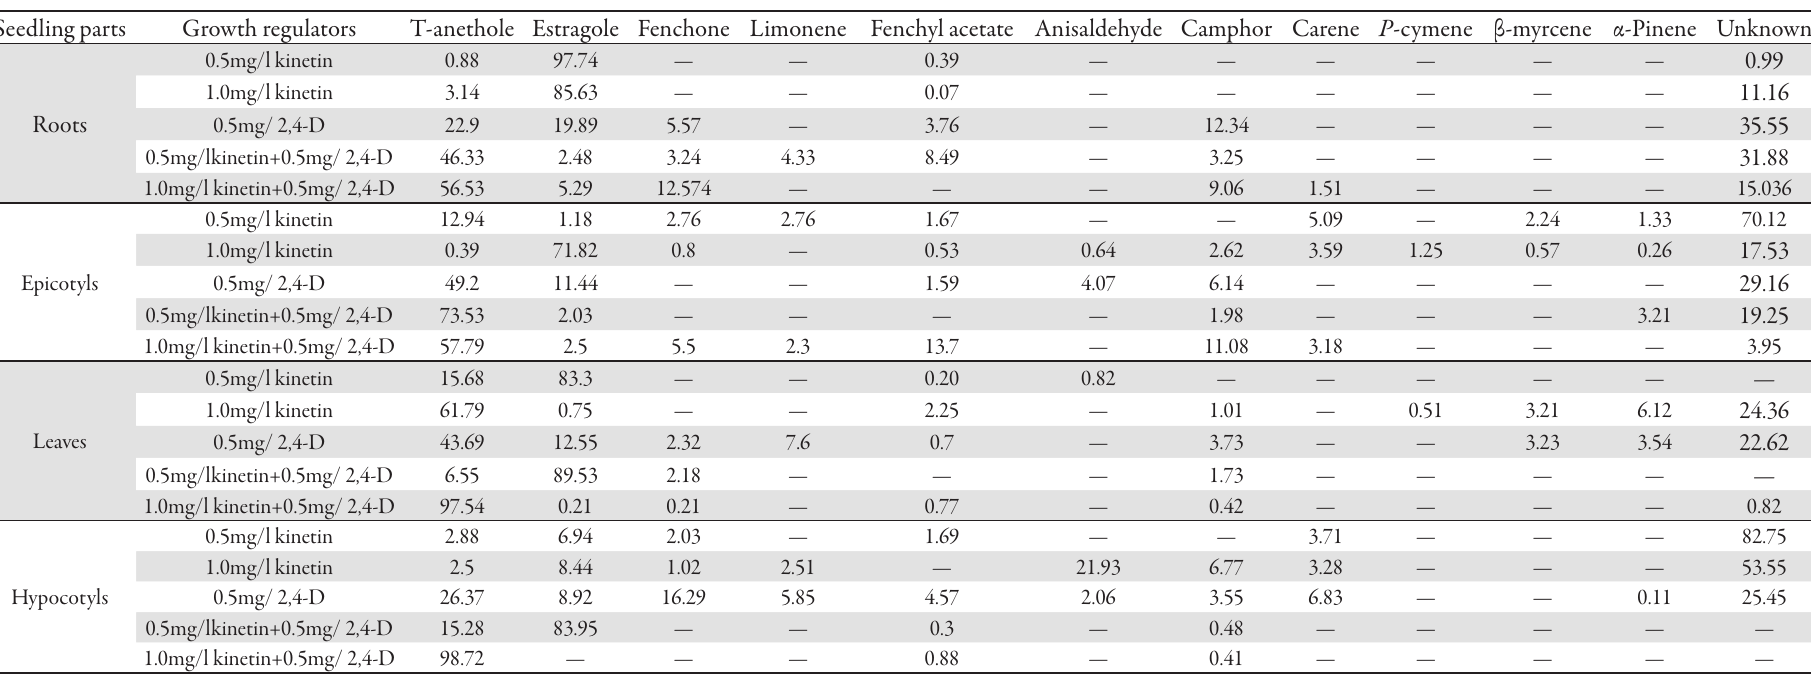
Tab. 5. Effect of different concentrations of kinetin, 2, 4-D on relative percentage composiotion of the volatile oils from callus induced from different seedling parts of fennel ( Foeniculum vulgare